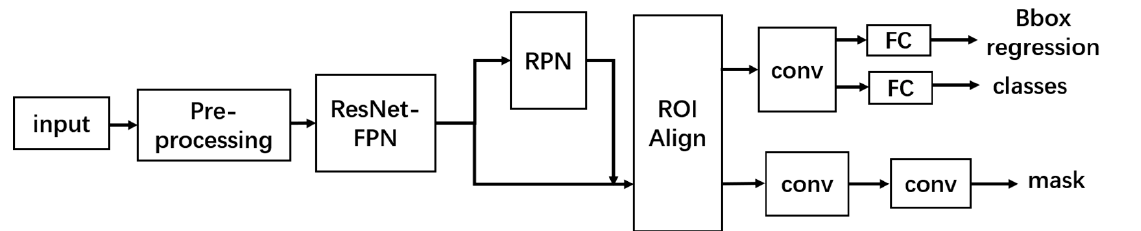
Figure 1. The network structure of improved Mask R-CNN.